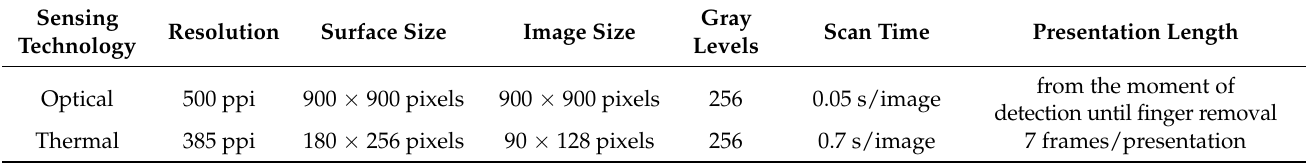
Table 4. Comparison of the used sensors in the data collection.